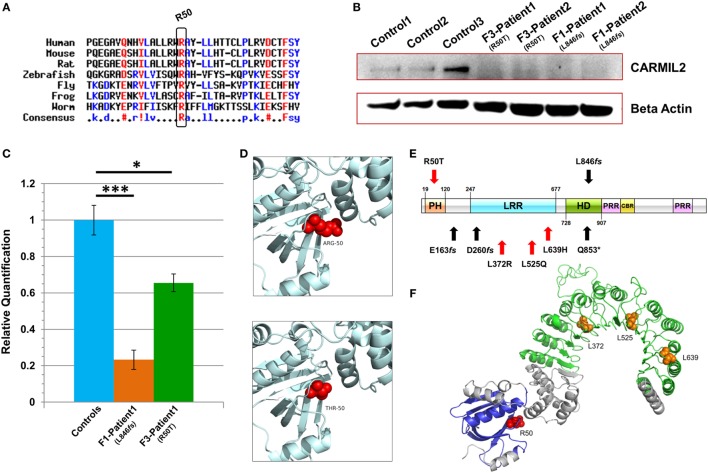
Characterization of CARMIL2 mutations. (A) Protein sequence alignment reveals that the Arg-50 residue is highly conserved across species. (B) Immunoblot reveals absence of detectable CARMIL2 protein in lymphoblastoid cells from patients with the missense and frameshift mutations. For the latter, no bands were found at the calculated molecular weight of the truncated protein (Figure S3 in Supplementary Material). The beta actin lane serves as a loading control. (C) Real-time RT-PCR data for CARMIL2 expression levels in lymphoblastoid cells from the index cases for families F1 and F3 versus combined data from two normal controls. Asterisks indicate significance levels (*p < 0.05, ***p < 0.001; unpaired Student’s t-test). Error bars indicate SEMs. Data were acquired through two independent experiments conducted in triplicate. (D) The 3D homology models established using the native and mutant amino acids at position 50. (E) Schematic representation of the CARMIL2 protein. Previously reported mutations are listed under the schematic, and those from this study are listed above. Missense mutations are indicated in red, and frameshift in black. The depicted domains include the pleckstrin homology domain (PH), the leucine-rich repeat (LRR), the homodimerization domain (HD), the proline-rich regions (PRR), and the capping protein binding region (CBR). Domain boundaries are approximate and are based on homology with known CARMIL1 domains (12) as well as previous CARMIL2 domain delineation (13). (F) 3D modeling of the N-terminal half of native CARMIL2, with the PH domain in blue and the LRR horseshoe region in green. All previously reported missense mutations (orange) have involved leucine residues within the LRR, whereas the one reported in this study (red) is an arginine that does not show interaction with that domain.